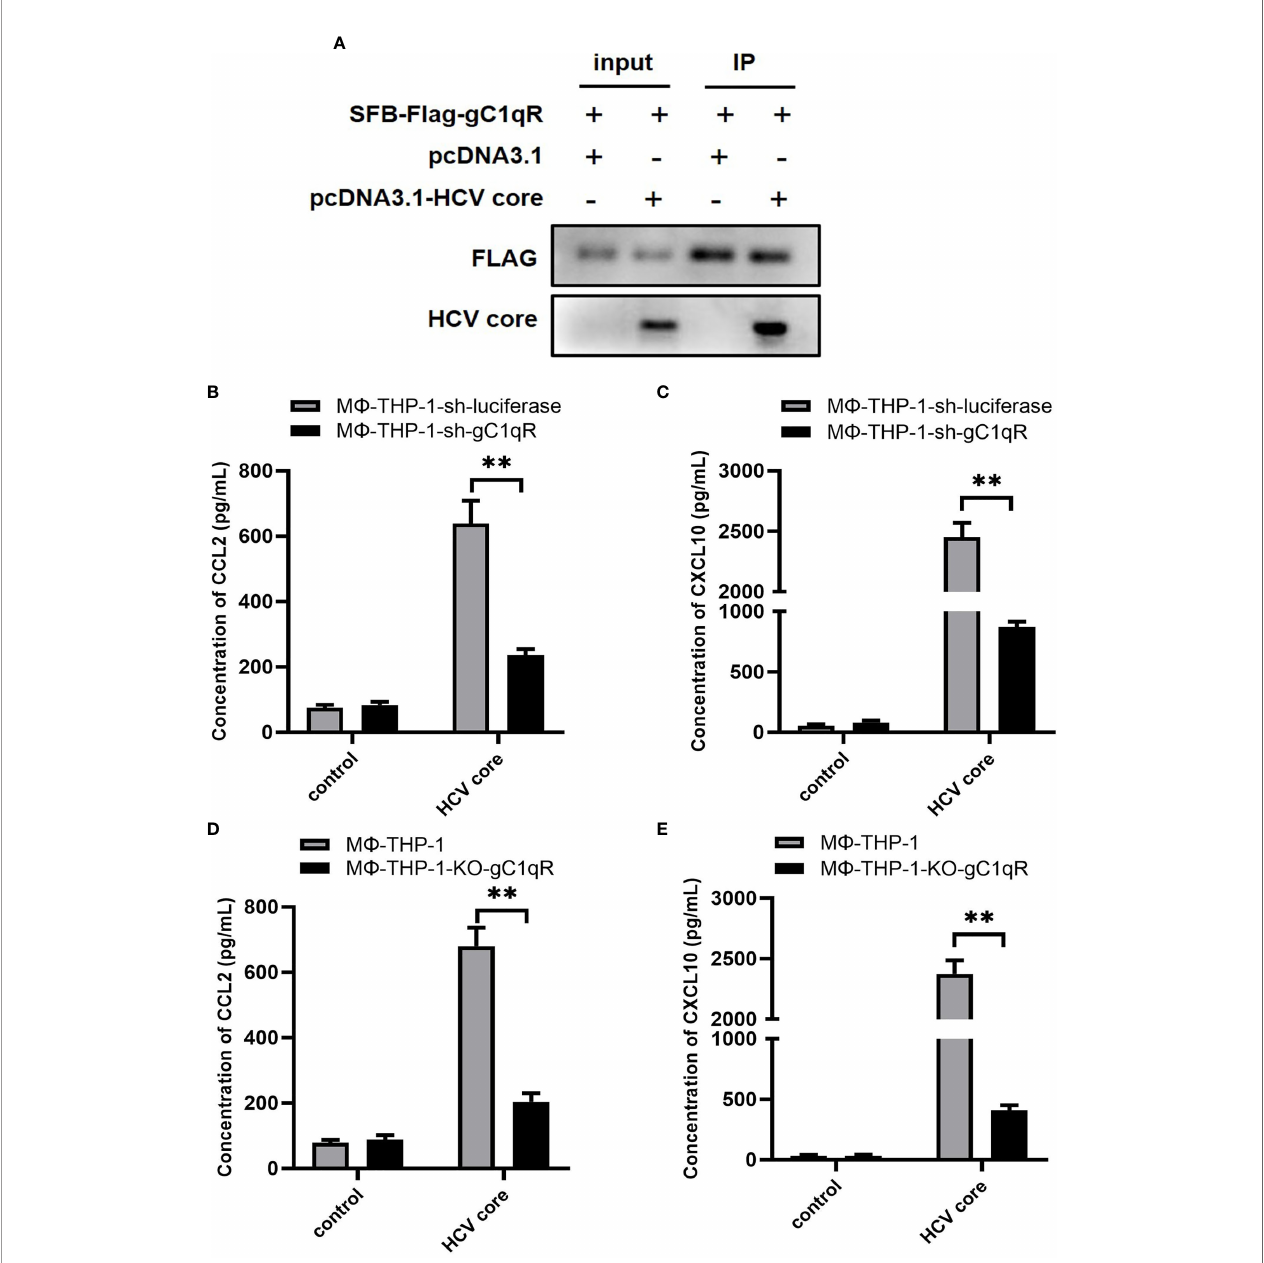
FIGURE 3 | gC1qR is involved in the expression of CCL2 and CXCL10 in macrophages. (A) HEK 293T cells were co-transfected with SFB-Flag-gC1qR and pcDNA3.1-HCV core plasmid (co-transfected SFB-Flag-gC1qR and pcDNA3.1 plasmid as control group) for 48 h. Cells were lysed with NTEN buffer and analyzed by immunoprecipitation and immunoblotting using antibodies of FLAG and HCV Core protein. (B, C) gC1qR knock-down cell line (M F -THP-1-sh-gC1qR) and control cell line (M F -THP-1-sh-luciferase) were either treated or untreated with HCV core protein (10 m g/mL) for 24 h. Cell culture supernatants were collected and analyzed for CCL2 and CXCL10 production using ELISA kits. (D, E) gC1qR knock-out cell line (M F -THP-1-KO-gC1qR) and control cell line (M F -THP-1) were either treated or untreated with HCV core protein (10 m g/mL) for 24 h. Cell culture supernatants were collected and analyzed for CCL2 and CXCL10 production using ELISA kits. Data are shown as mean ± SD for three independent experiments. ** p <